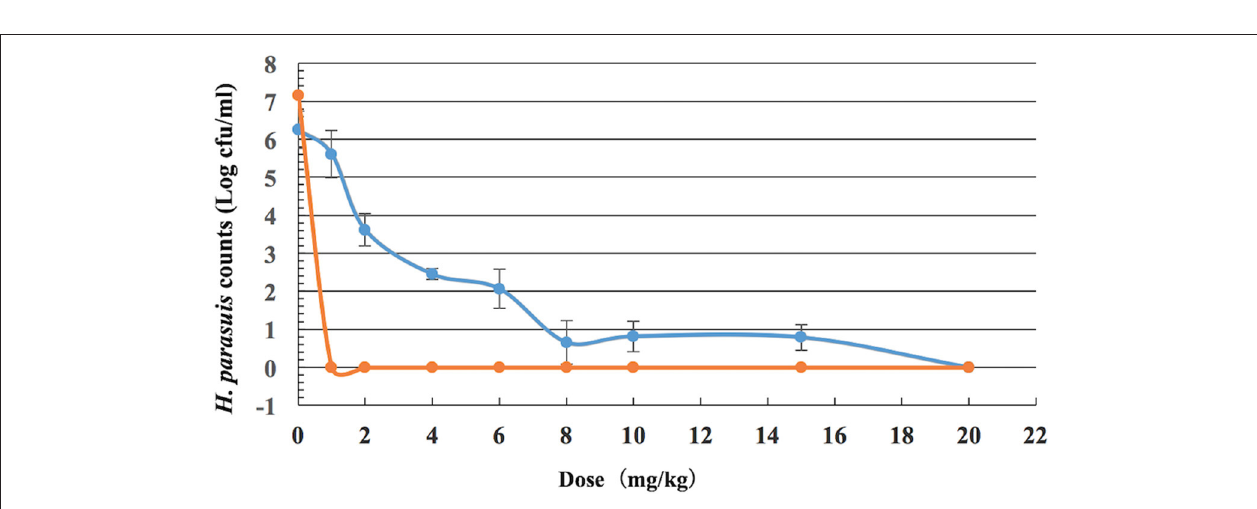
FIGURE 3 | Viable counts of H. parasuis in blood and lung tissues of guinea pigs after a single dose of tulathromycin ( n =